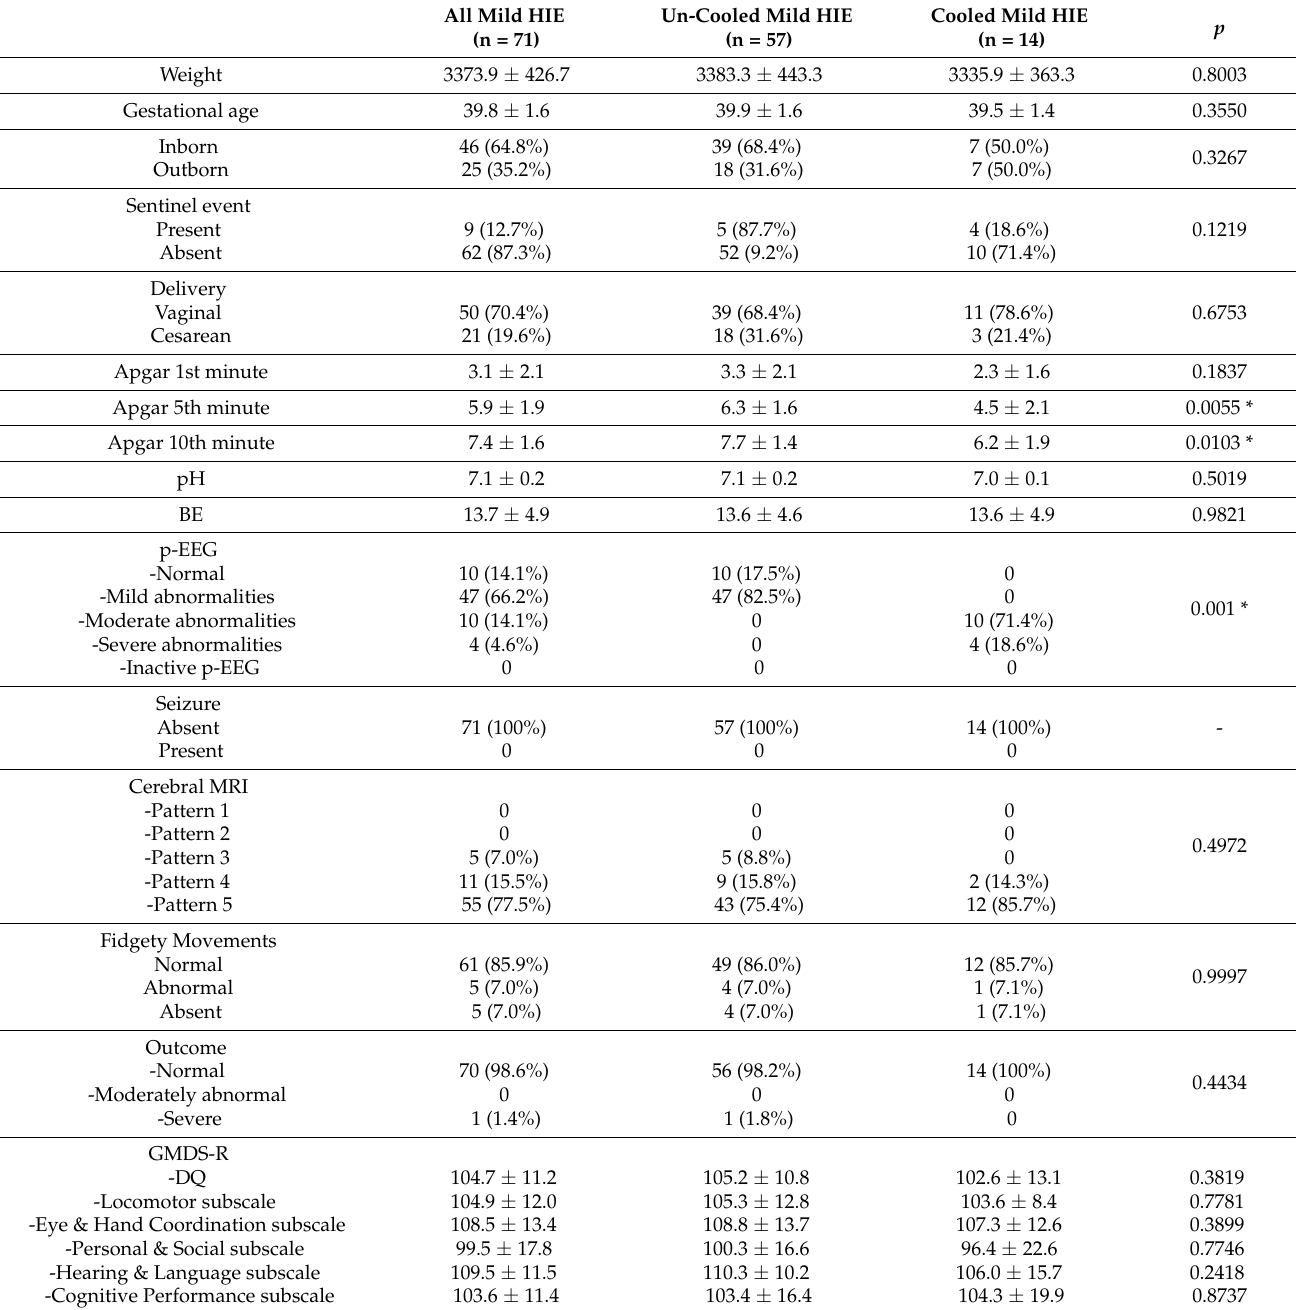
Table 6. Comparison of cooled and un-cooled neonates with mild